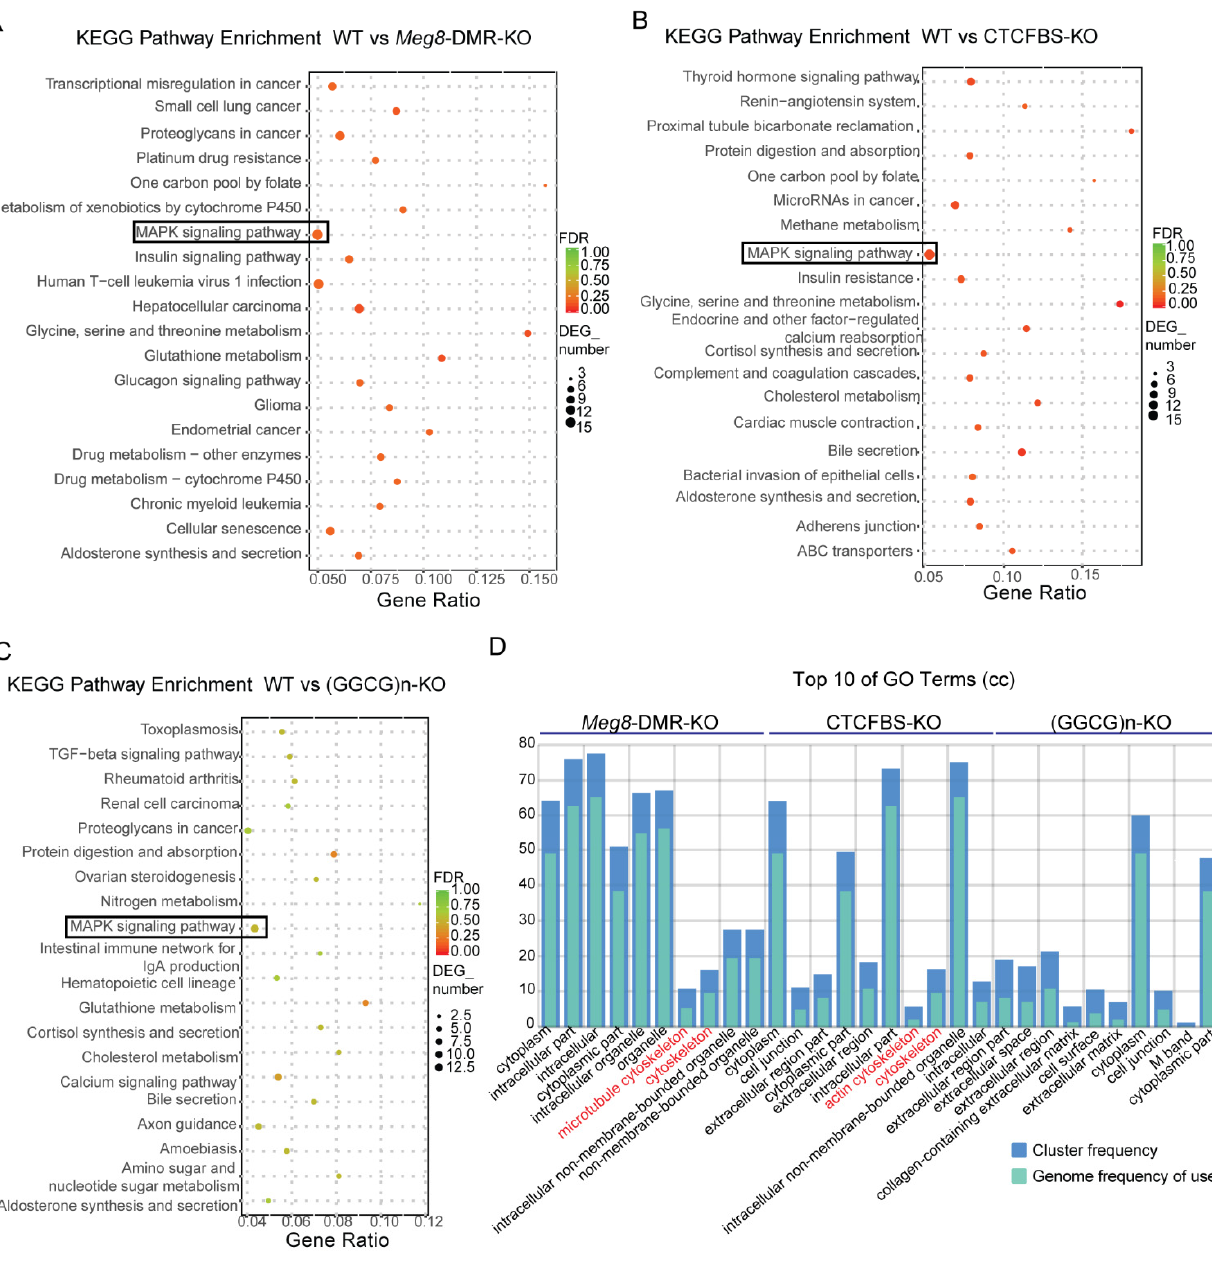
Figure 4. DEGs Functional Analysis of the Meg8 -DMR deletion cell lines. ( A – C ) Top 20 of KEGG pathway enrichment of genes differentially expressed in Meg8 -DMR-KO, CTCFBS-KO, and (GGCG)n- KO. ( D ) Top 10 GO terms of cellular component (CC) of GO enrichment analysis of differentially expressed genes in Meg8 -DMR-KO, CTCFBS-KO and